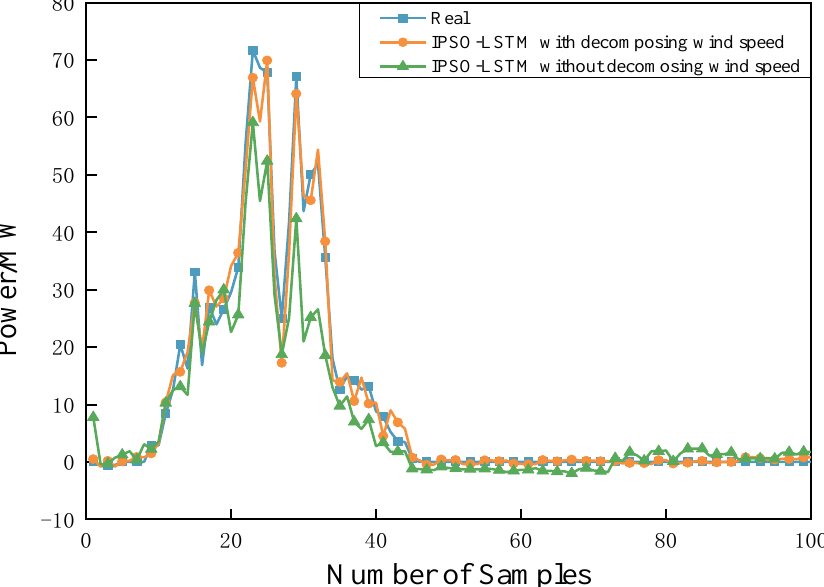
Figure 9. Predicted results with and without decomposing wind speed.